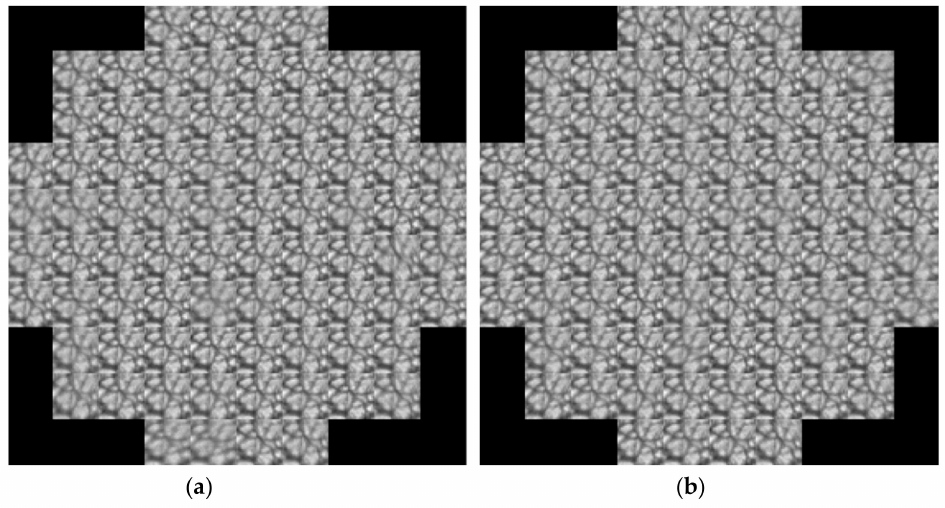
Figure 6. Examples of two SH measures for the same frame of the solar image, with turbulences at: ( a ) 2 km (left) and ( b ) 7.5 km